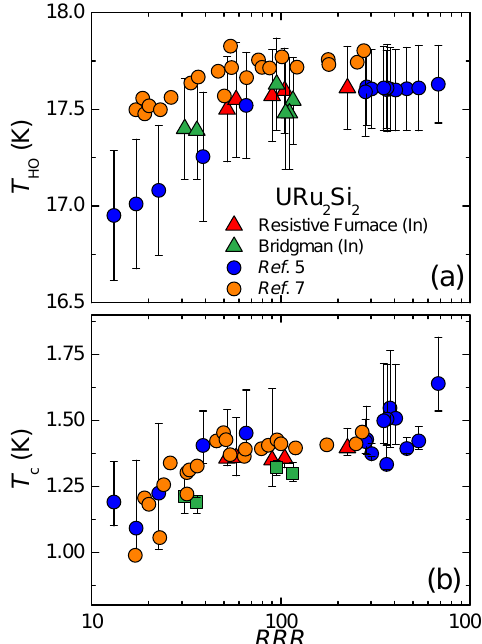
Figure 4. Comparison between URu 2 Si 2 crystals grown by the two-step Czochralski/zone-refining (as performed by two different groups) [5–7], molten indium flux [5,16], and those that were produced using the modified Bridgman growth discussed here. ( a ) Dependence of the hidden order transition temperature T 0 on the residual resistivity ratio RRR = ρ 300K / ρ 0 , where RRR is defined in the main text. The bars represent the transition width as defined in Figure 3. Note that RRR is presented on a logarithmic scale. ( b ) The superconducting transition temperature T c vs. RRR . The bars represent the transition